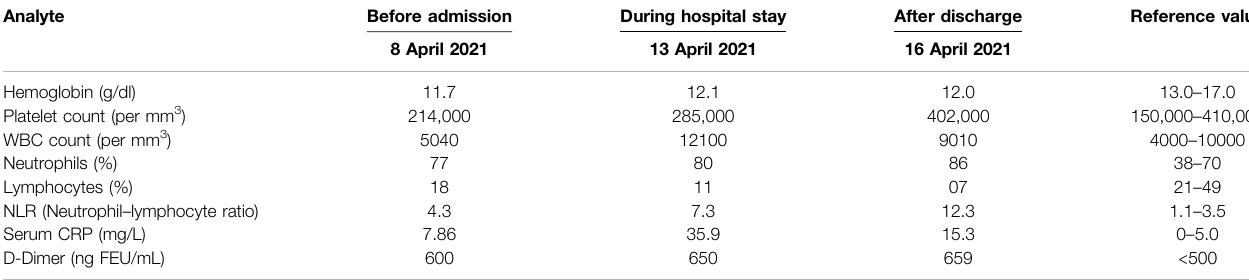
TABLE 1 | Serial laboratory values of patient S.D. Analyte